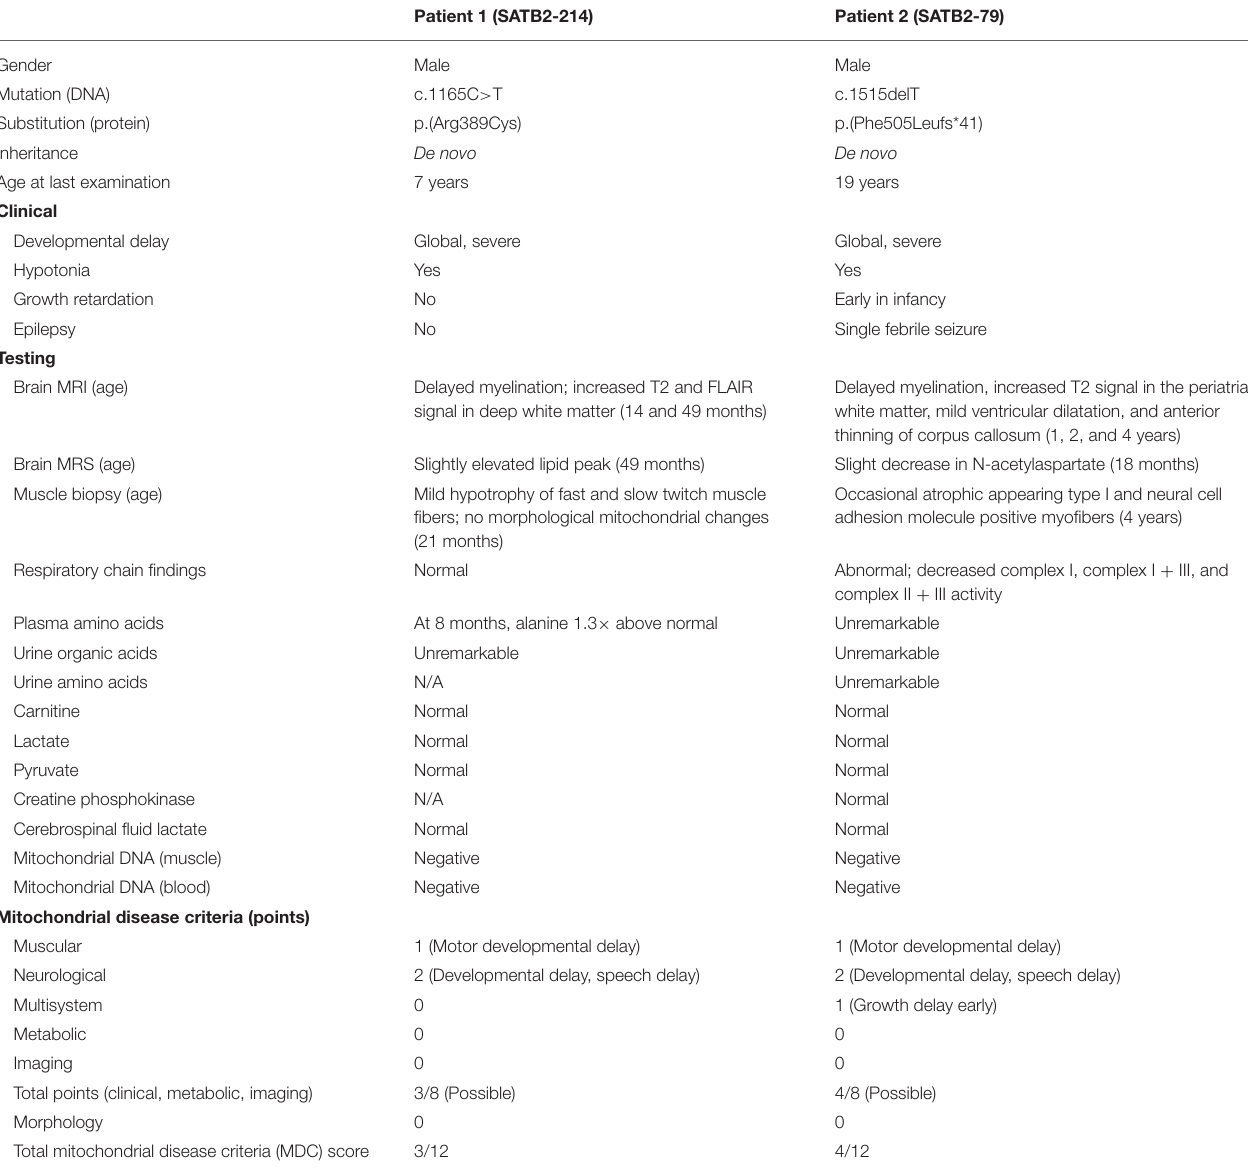
TABLE 1 | Clinical characteristics of two individuals with SATB2 -associated